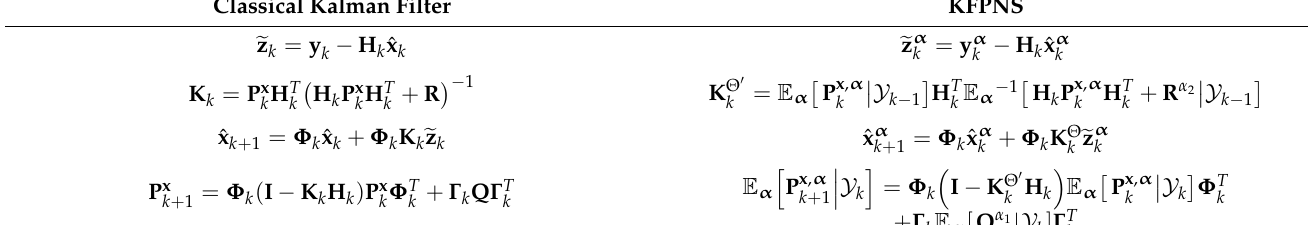
Table 1. Comparison of the recursive equations for the classical algorithm and KFPNS. Classical Kalman Filter KFPNS